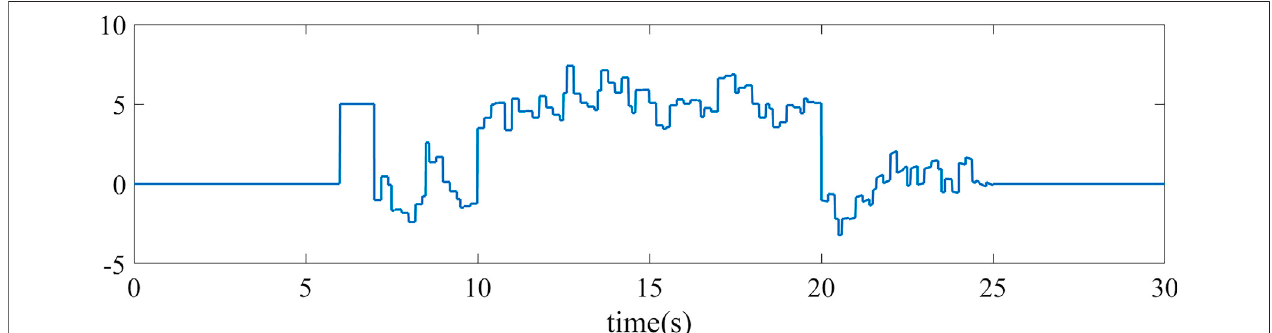
FIGURE 8 | External interference signal.